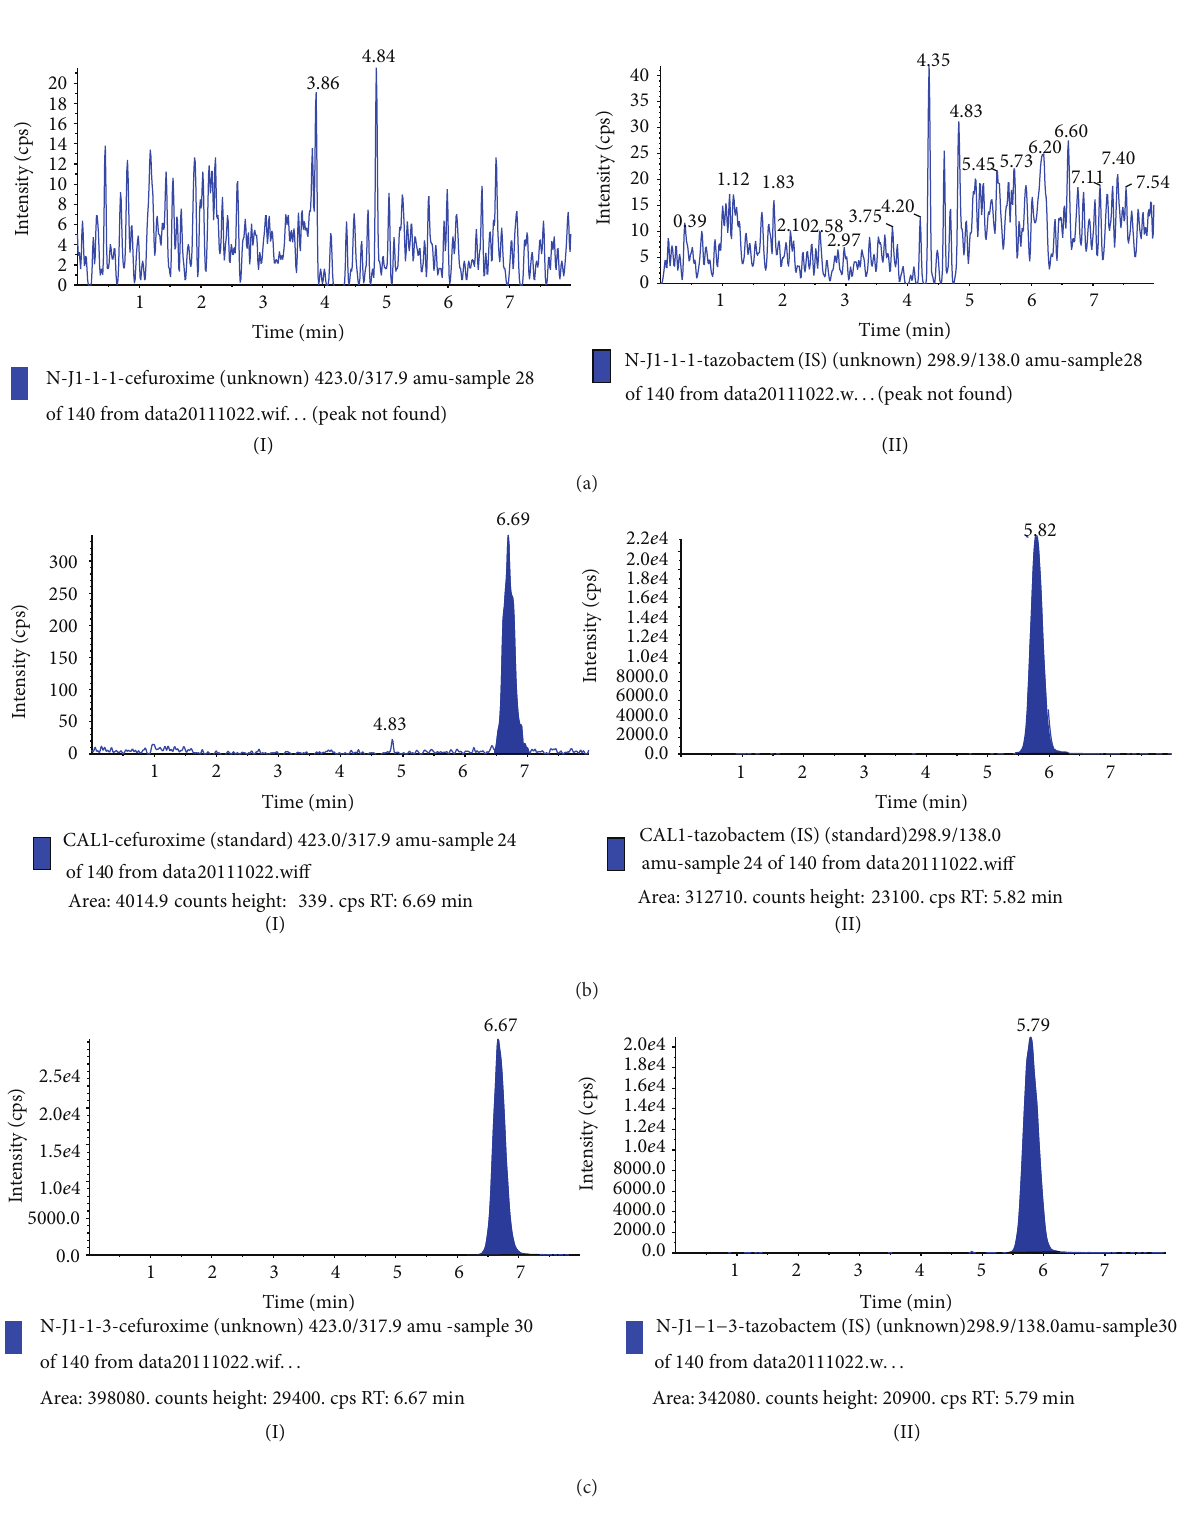
Figure 2: MRM chromatograms of cefuroxime (I) and IS (II) obtained from human plasma samples: (a) blank plasma, (b) blank plasma spiked with standard solution (LLOQ), and (c) plasma sample from a healthy subject 0.67 h after oral